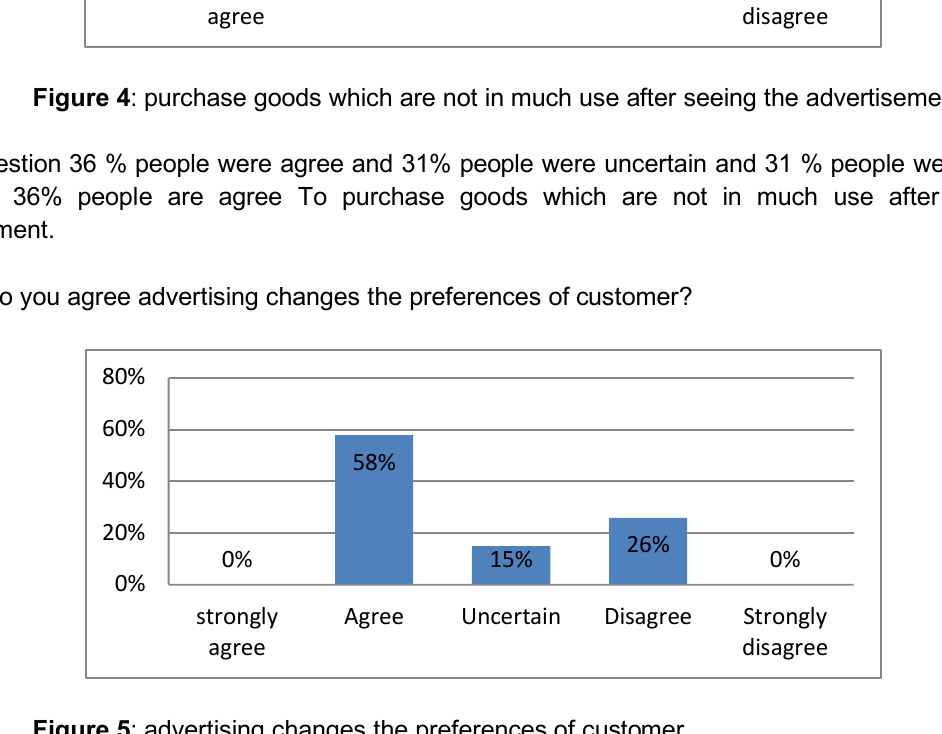
Figure 5 : advertising changes the preferences of customer.